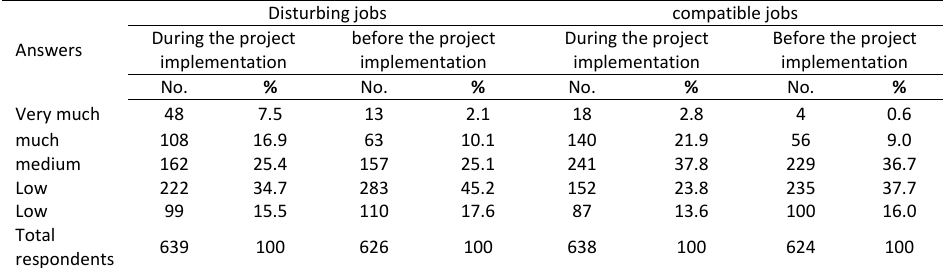
Table 2: Comparison of disturbing occupations and adapted jobs before and during construction of the project from the viewpoint of the residents Disturbing jobs Answers